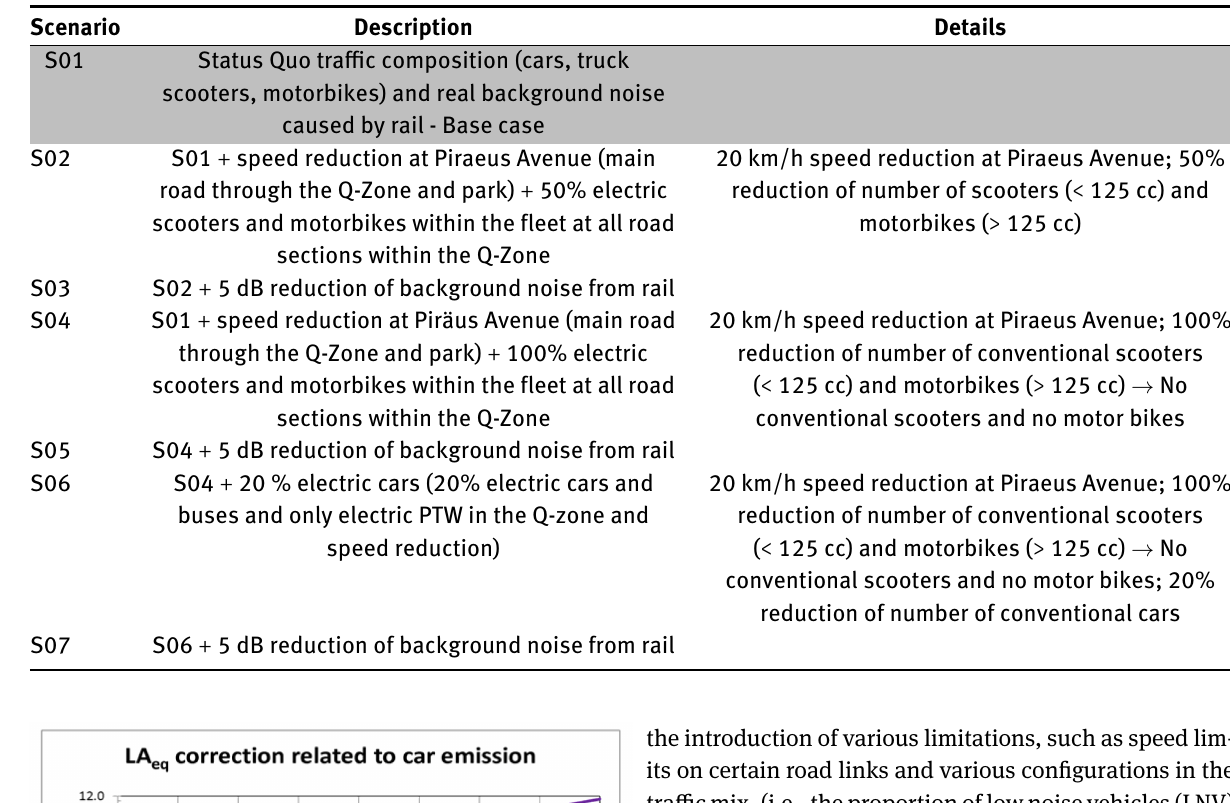
Table 2: Q-Zone scenario configurations in Athens test site.